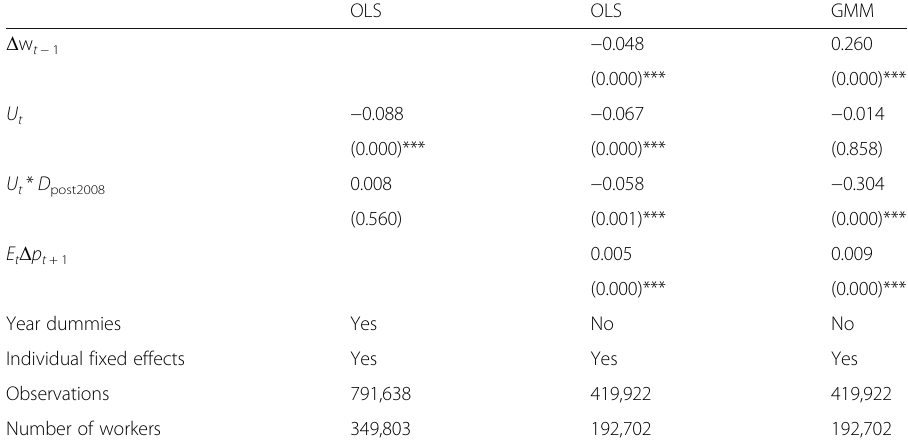
Table 7 Wage Phillips curve in Italy: individual estimates; fixed-term workers ( p values in brackets) OLS OLS GMM Δ w − 0.048 0.260 t − 1 (0.000)*** (0.000)*** U − 0.088 − 0.067 − 0.014 t (0.000)*** (0.000)*** (0.858) U t * D − 0.058 − 0.304 post2008 0.008 (0.560) (0.001)*** (0.000)*** E t Δ p t +1 0.005 0.009 (0.000)*** (0.000)*** Year dummies Yes No